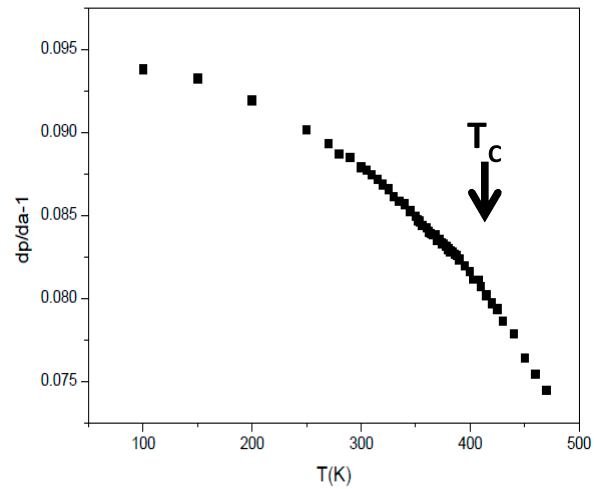
Figure A2. Example of a smooth transition in the parent compound MnFeP 0.5 Si 0.5 , directly received from atomization and ferromagnetically ordering close to the 390–400 K Plot of the δ = d ( 2 c -2 c )/ c − 1 index versus temperature shows no noticeable magnetoelastic effect. leading to almost no variation of magnetic entropy at transition as reported in Figure 11. In fact, this atomized material exhibits ~12% of Mn 3 Fe 2 Si 3 as impurity and some atomic disorders in the Fe 2 P-type structure, preventing an established collective magnetoelastic phenomenon.